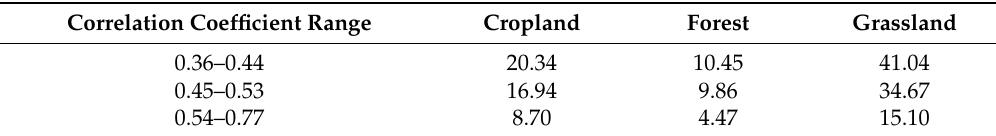
Table 2. Percentage of the area in each land cover class with Normalized Difference Vegetation Index (NDVI)/Air temperature correlation.